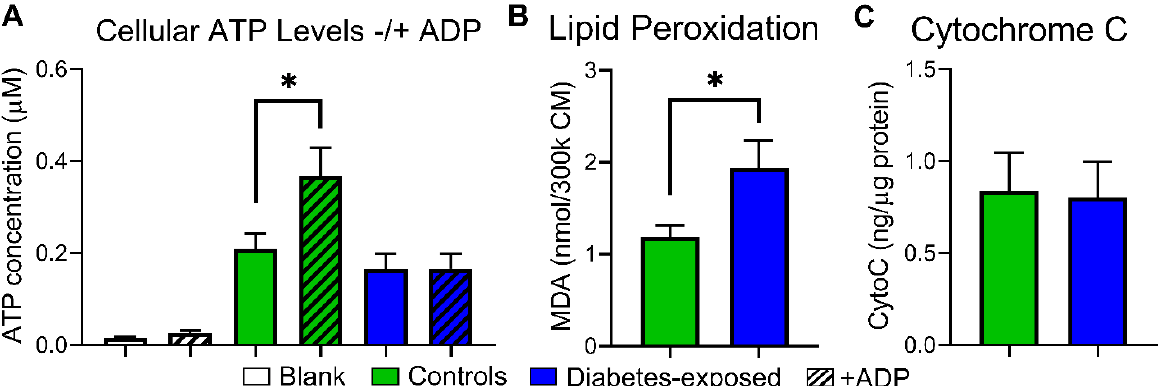
Figure 4. PGDM-exposed cardiomyocytes suffer from impaired phosphorylation and increased lipid peroxidation. ( A ) Cellular ATP levels with and without addition of ADP. Left two columns show media (negative control). ( B ) Malondialdehyde (MDA) was measured as a surrogate marker for lipid peroxidation. ( C ) Cytosolic cytochrome C levels at baseline, i.e., not under stress. N = 8–10 per group (sexes combined). Data represent mean ± SEM. * P ≤ 0.05 by 1-way ANOVA ( A ) or T-test ( B ).